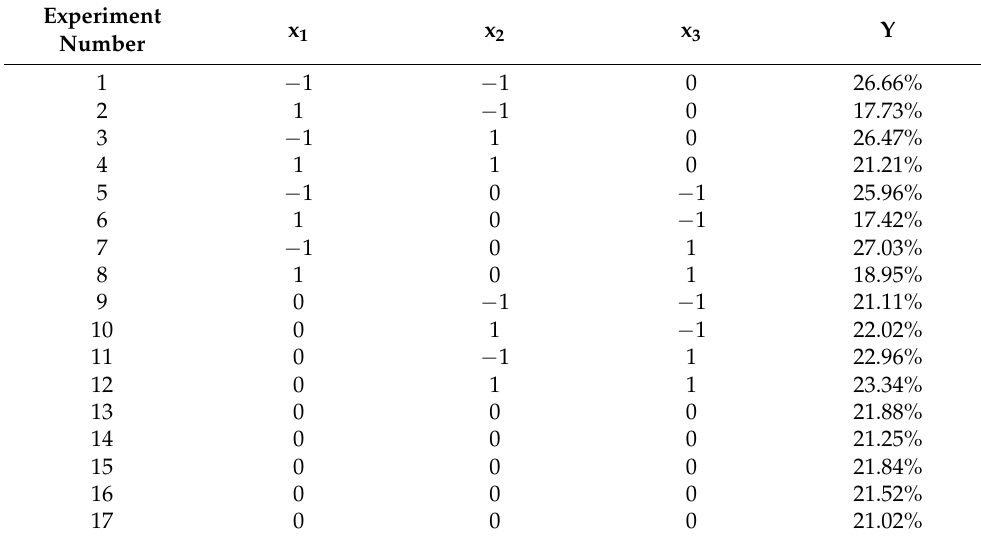
Table 6. Experimental design and